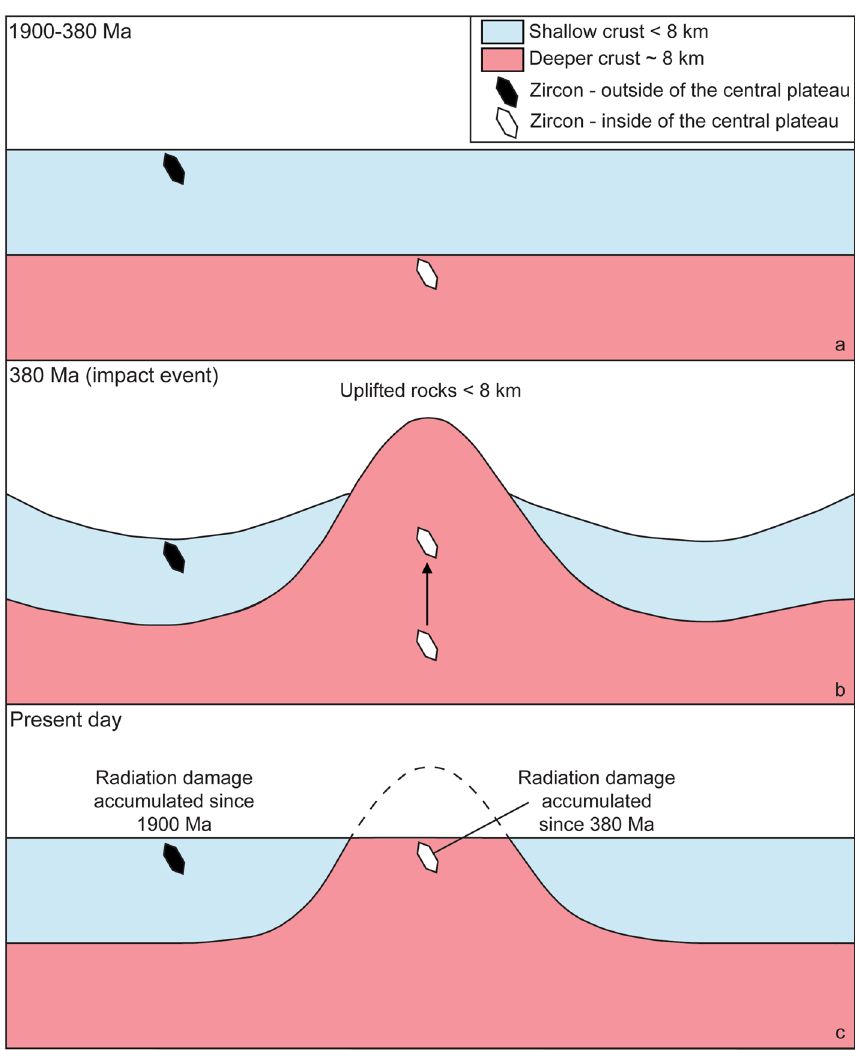
Figure 4. Cross-sections illustrating the evolution of the Siljan area prior ( a ), during ( b ) and after ( c ) the impact event. ( a ) Illustrates the crust in the period 1900–380 Ma. The different depth of zircon outside (black grain) and inside (white grain) the central plateau is shown. The zircon outside the central plateau resided near the surface where radiation damage accumulated since at least 1260 Ma. Zircon inside the central plateau resided at ~ 8 km depth and annealed continuously. ( b ) The impact event caused ~ 8 km uplift of the central plateau, exposing zircon to surface conditions since 380 Ma. ( c ) Present situation, zircon from both out- and inside the central plateau resides at surface (figure created with Adobe Illustrator version v. 25.0.1, https:// www. adobe. com/ produ cts/ illus trator. html? promo id= PGRQQ LFS& mv=